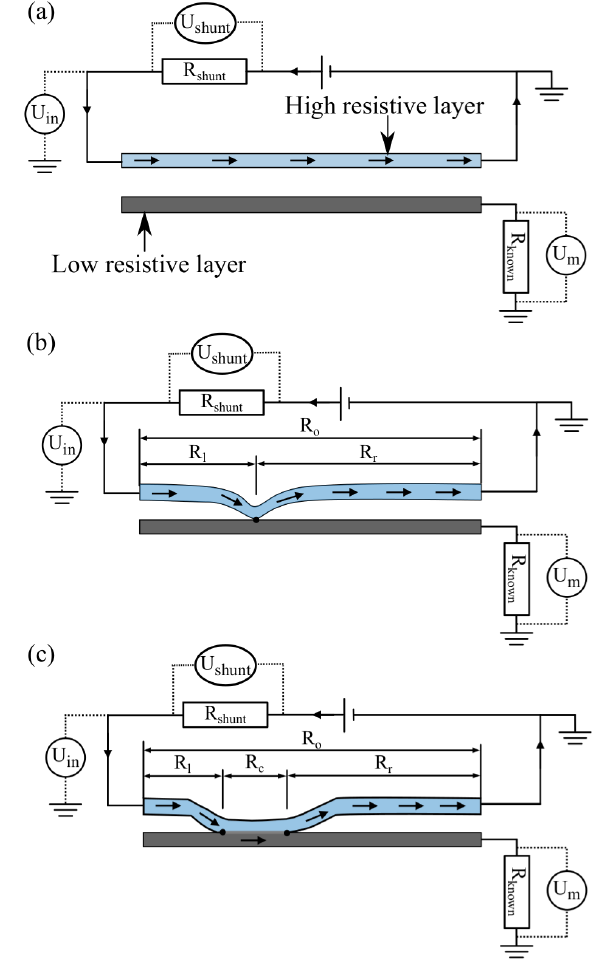
Figure 5. Electrical schematic diagram of sensor: (a) no crash, (b) single-point contact and (c) multi-point